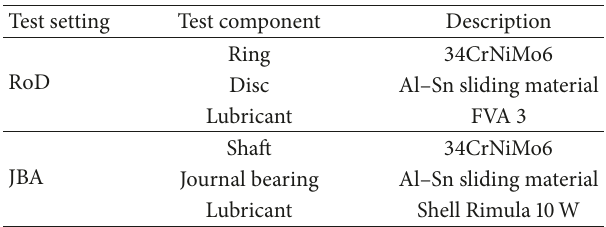
Table 1: Used test components.